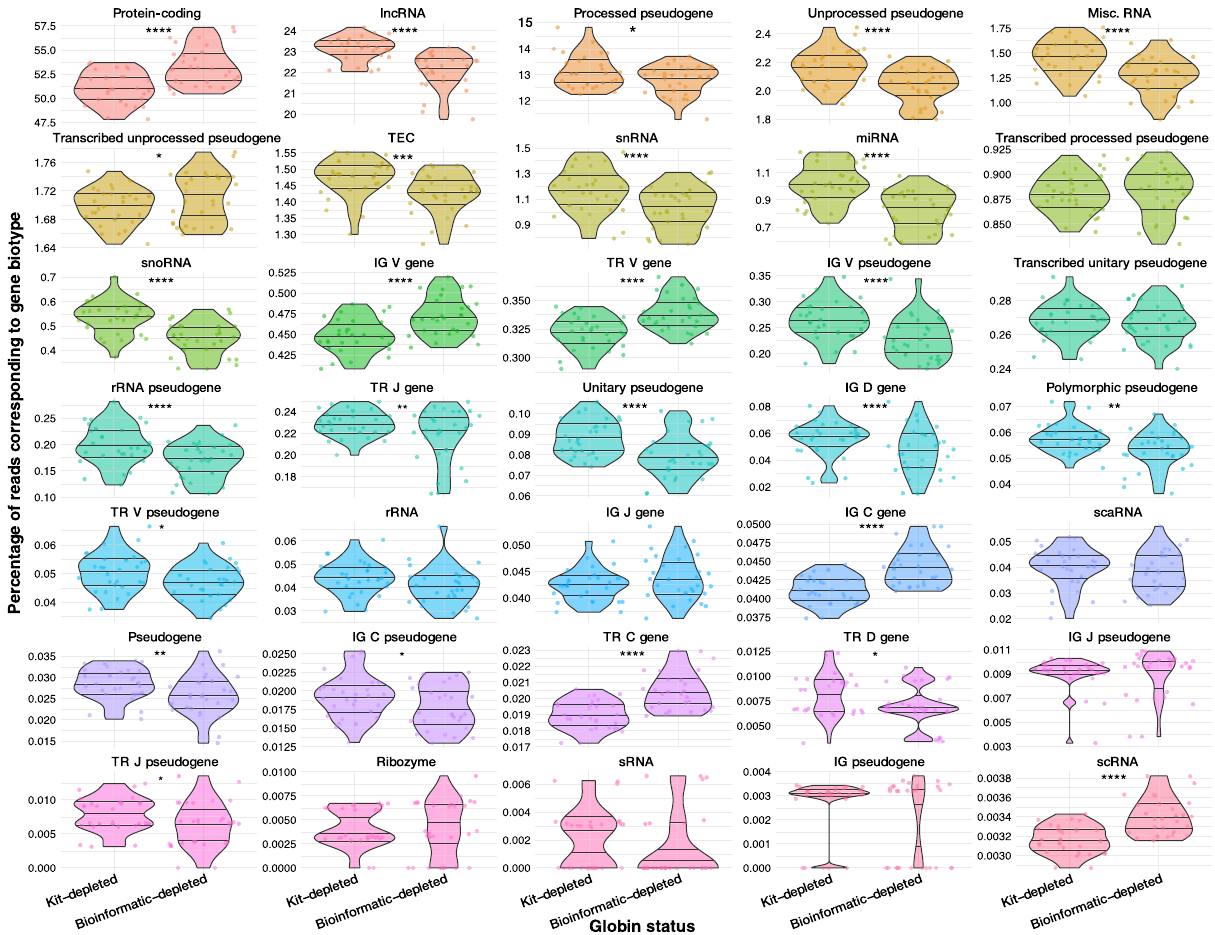
Figure 2. Distributions of reads mapping to distinct gene biotype regions of the genome between kit- and bioinformatic-depleted samples. Violin plots depicting the distribution of the proportion of reads from each library method ( n = 29 samples per method) mapping to portions of the genome associated with specific gene biotypes. Percentages were calculated after the bioinformatic removal of haemoglobin protein-coding genes from all samples. Each dot represents and individual sample from each library method. Horizontal lines indicate the median, 1st quartile and 3rd quartile while the ends of the “violin” indicate the lower and upper adjacent values. A paired t test was performed to compare each group of samples with and without prior globin depletion and the Bonferroni-corrected p values are displayed; * < 0.05, ** < 0.005, **** <